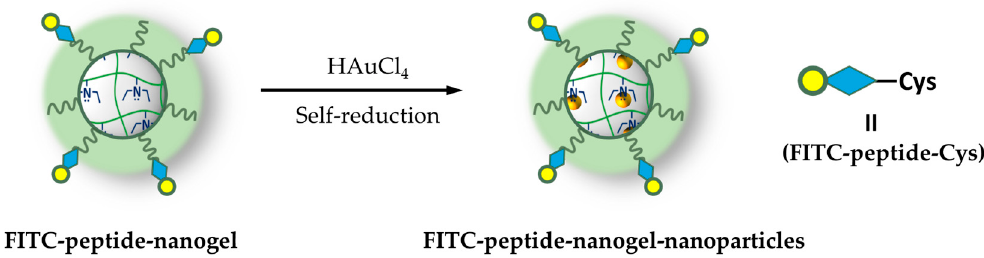
Figure 3. The PEGylated nanogel containing gold nanoparticles and fluorescein isothiocyanate-labeled peptides.